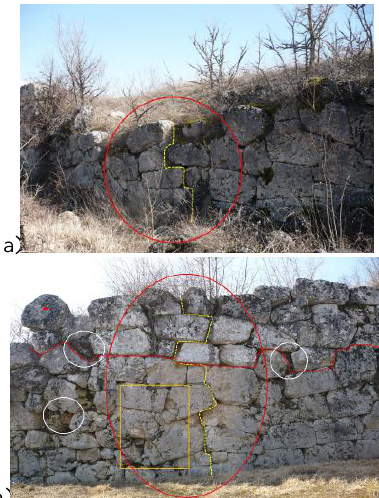
Figure 10. Megalithic walls a) left and b) right side of “Porta di Massa”. It is possible to observe the vegetation inside and above the walls, the washout (red circled zone), the bending (dashed yellow line) and the out-of-plane rotation (red dashed line), past maintenance interventions (the cutting of roots inside the wall (white circled zone)), cracking of the blocks (orange squared zone) produced by vertical actions. Single blocks instability (red spotted mark-top left) is reported.